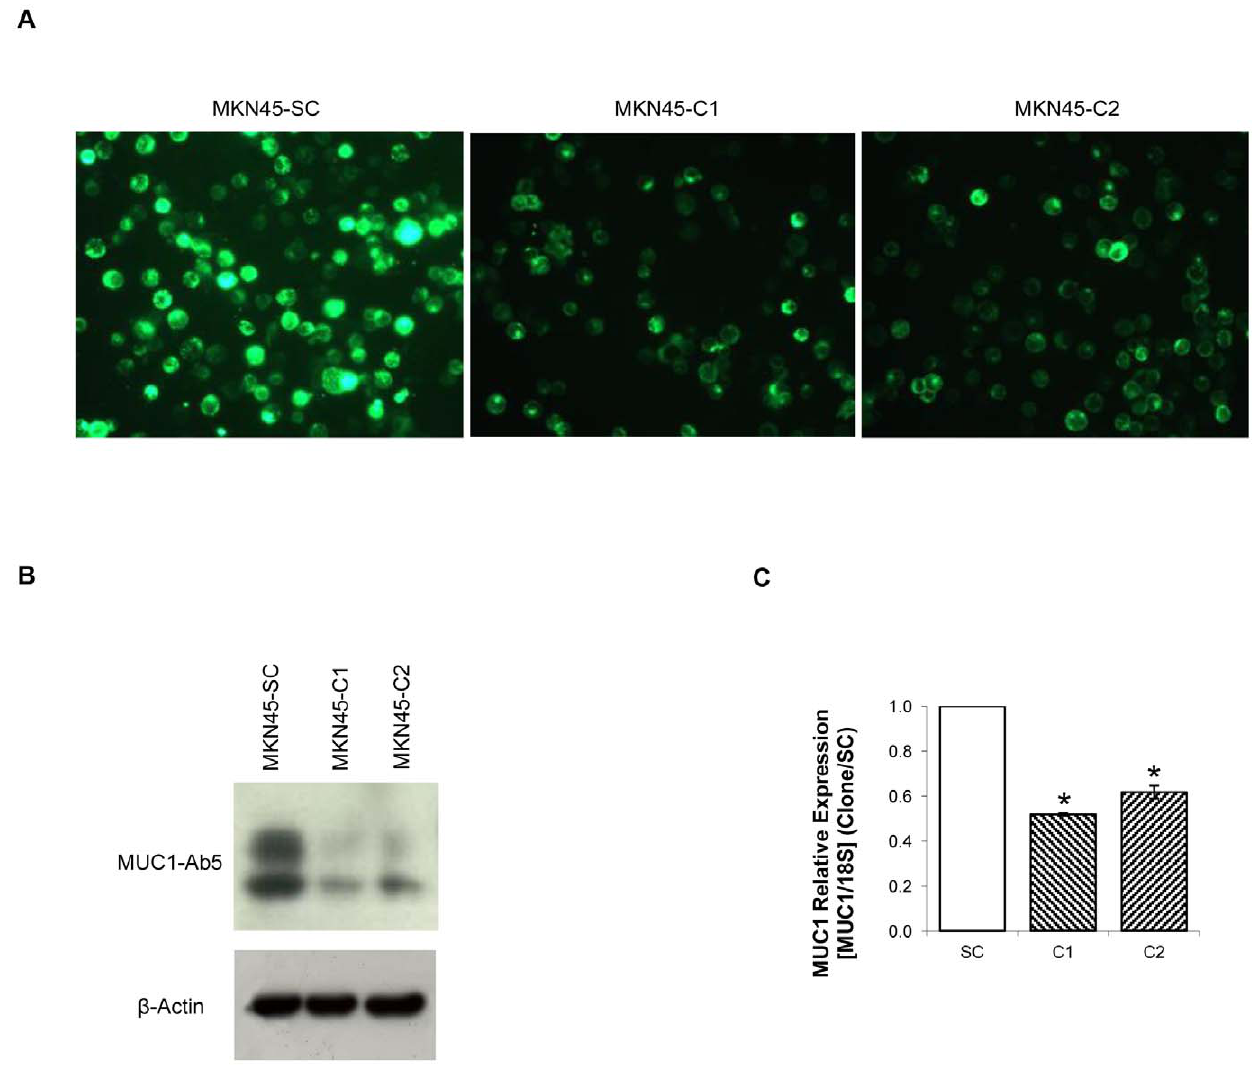
Figure 1. MUC1 downregulation by shRNA. ( A ) MUC1 detection by immunofluorescence with HMFG-1 antibody in MKN45-C1 and MKN45-C2 and MKN45-SC control; ( B ) MUC1 protein detection by western-blot with MUC1-Ab5 antibody of total protein extracts from MKN45-C1 and MKN45- C2 and MKN45-SC control; ( C ) Quantification of MUC1 RNA in MKN45-C1 and MKN45-C2 and MKN45-SC control by real-time PCR. MUC1 expression was corrected to the house-keeping gene 18S and normalized to the data obtained with the scrambled control. *P , 0.01.